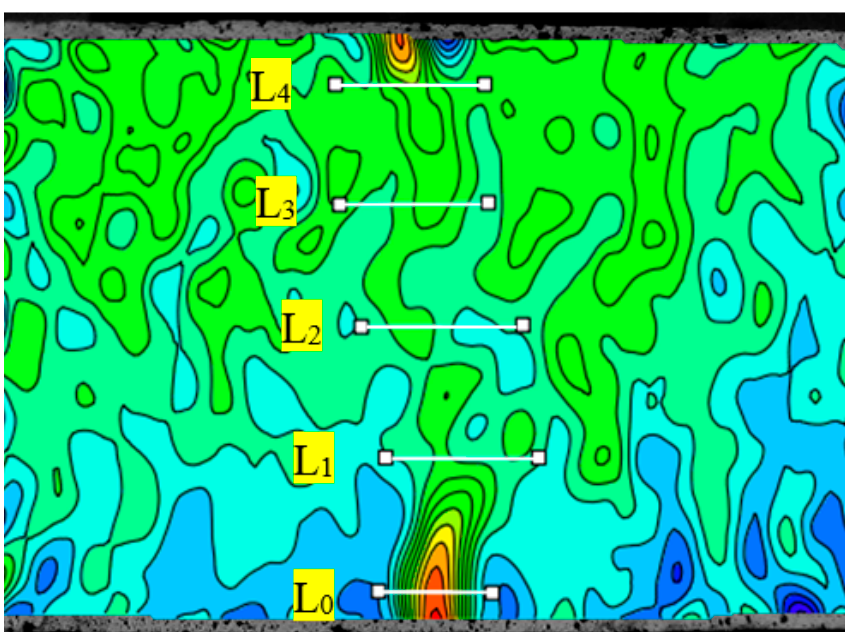
Figure 10. A schematic diagram of the virtual extensometers of a specimen (taking specimen CAR as an example).